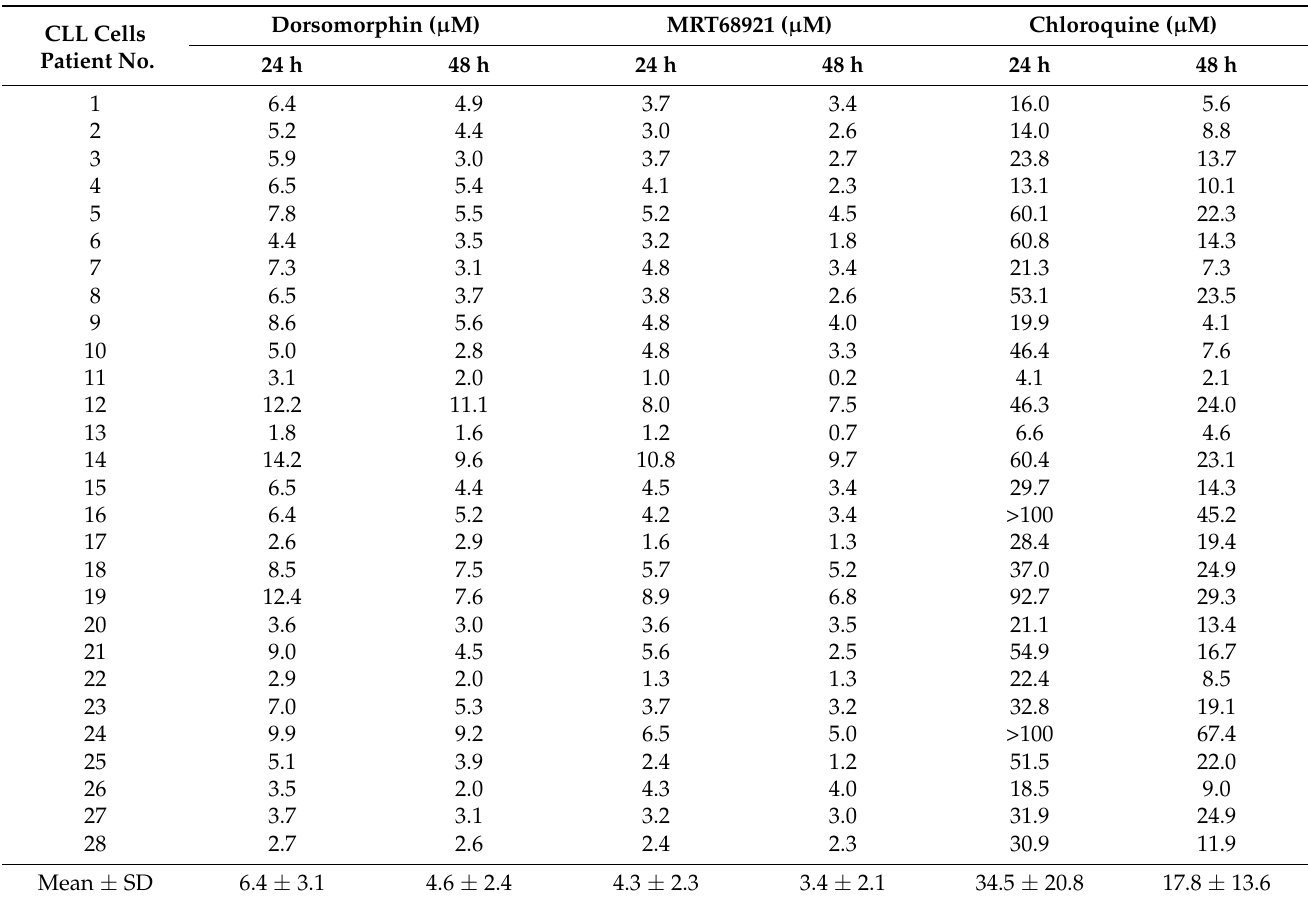
Table 2. The EC 50 values of autophagy inhibitors dorsomorphin, MRT68921, and chloroquine following 24-h and 48-h treatments of the primary CLL cells. CLL Cells Patient